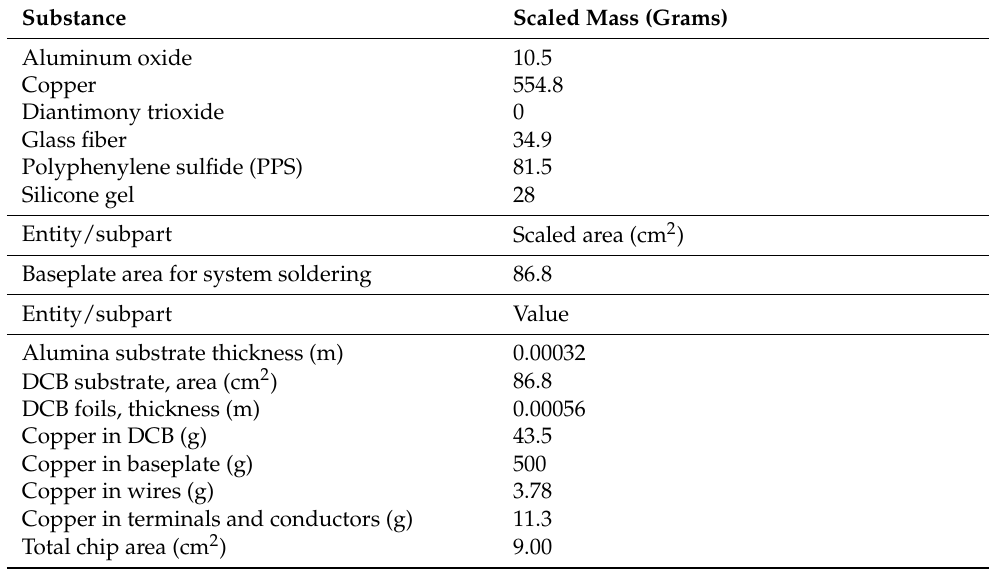
Table A1. Power module FS820R08A6P2B HybridPACK Drive.